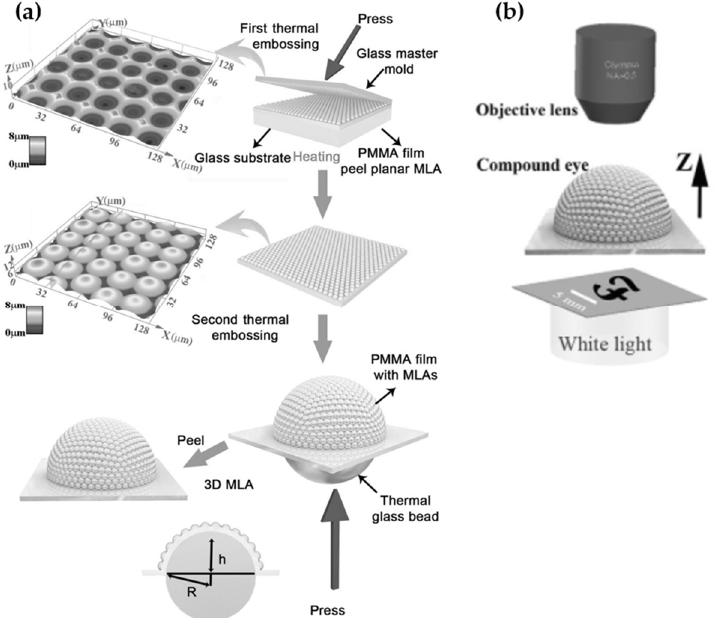
Figure 13. ( a ) The schematic diagram of fabrication process. ( b ) The optical setup experiment of curved MLA. Reproduced from [47] with permission of John Wiley and Sons.